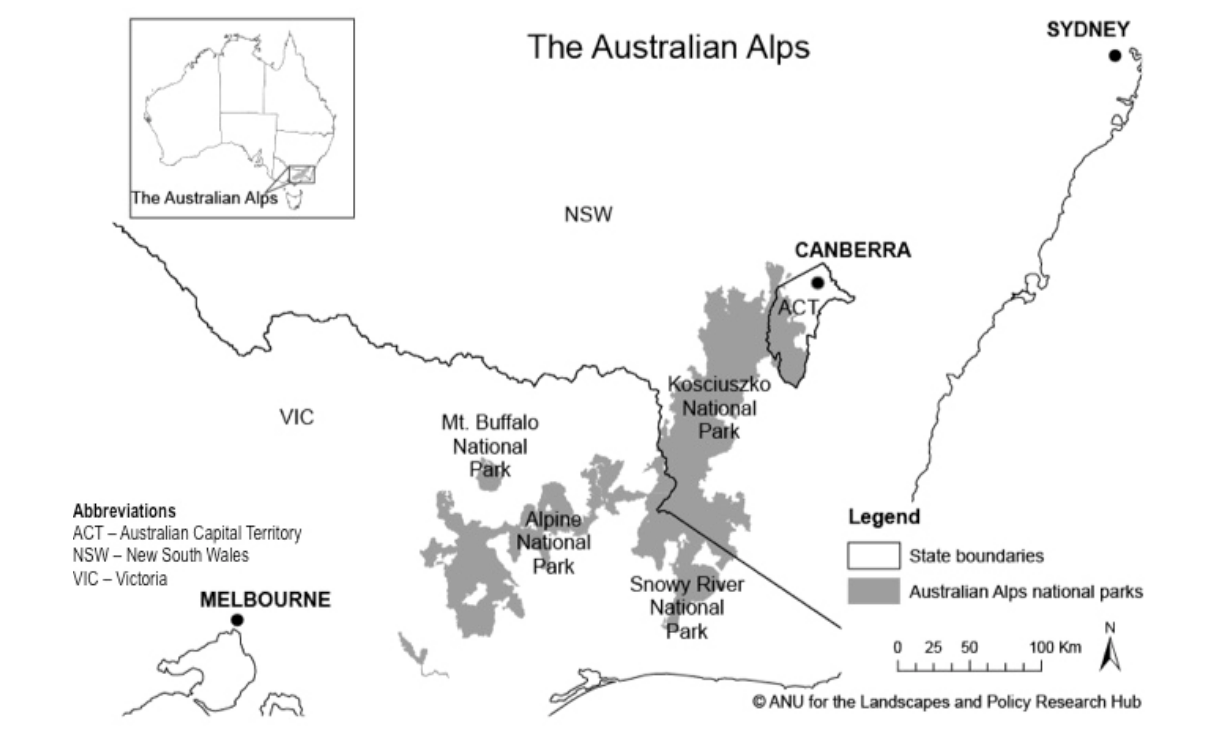
Fig. 2 . Location of Australian Alps protected